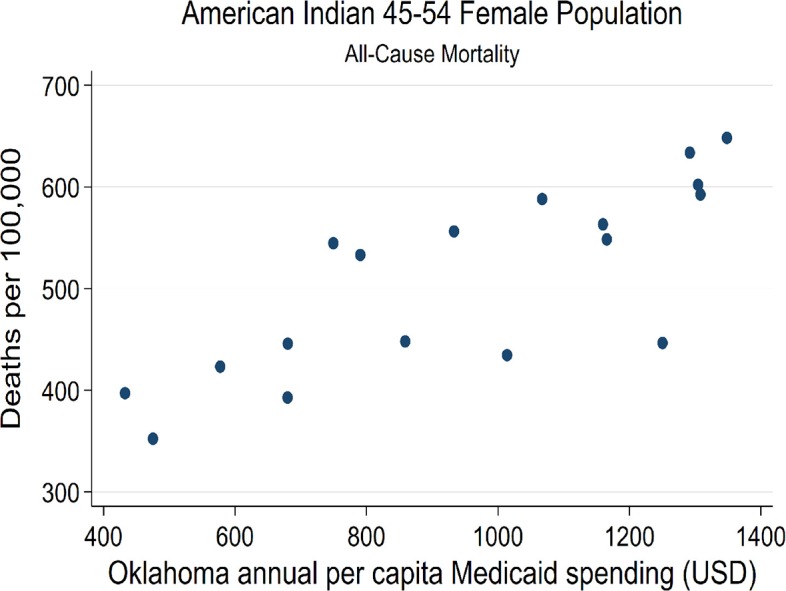
State-level Oklahoma Medicaid spending linear regression plot (crude association) with female AI45-54 all-cause mortality.